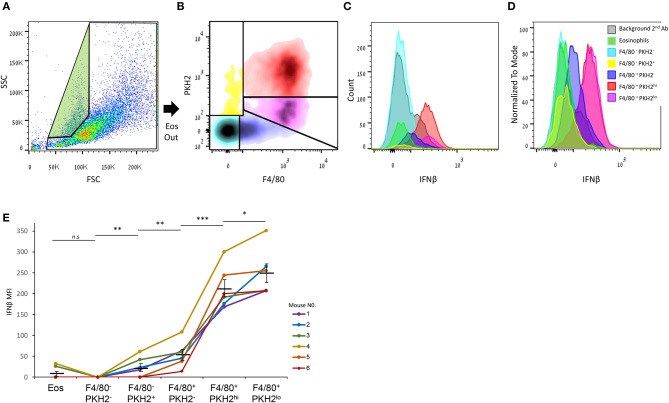
Satiated macrophages express the highest level of IFNβ of all resolution phase leukocytes. Peritoneal exudates were recovered from WT mice 66 h PPI, and the cells were immunostained for F4/80, fixed, permeabilized, and immunostained for IFNβ. (A) The gating strategy for eosinophils (green) and other immune cells. (B) Density plot analysis of F4/80 vs. PKH2 staining resulted in five distinct populations: F4/80−PKH2− (cyan), F4/80−PKH2+ (yellow), F4/80+PKH2− (blue), F4/80+PKH2hi (red), and F4/80+PKH2lo (purple). These populations were then analyzed for IFNβ expression, and results were presented as counts (C) and normalized to mode (D). MFI means ± SEM from six independent mice are shown (E). *P < 0.05, **P < 0.01, ***P < 0.001 (Student's t-test). Data for second antibody alone and eosinophils were previously reported in (17).